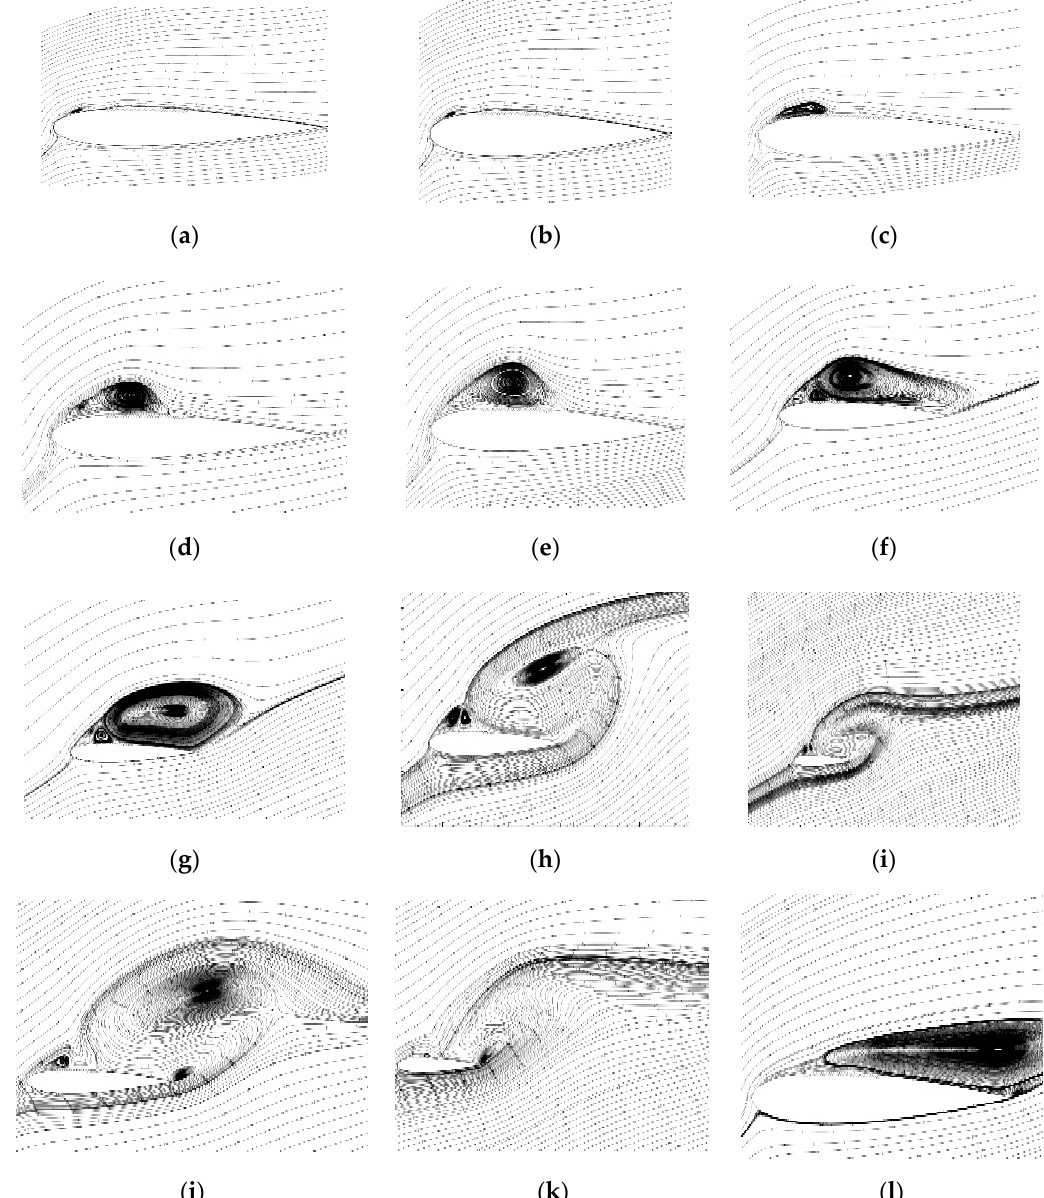
Figure 21. Streamline of NACA0012 airfoil with grooves on the suction side at a 19° angle of attack at different times. ( a ) t = 0.005 s, ( b ) t = 0.05 s, ( c ) t = 0.1 s, ( d ) t = 0.2 s, ( e ) t = 0.3 s, ( f ) t = 0.4 s, ( g ) t = 0.5 s, ( h ) t = 0.6 s, ( i ) t = 0.7 s, ( j ) t = 0.8 s, ( k ) t = 0.9 s, and ( l ) t = 1.0 s.